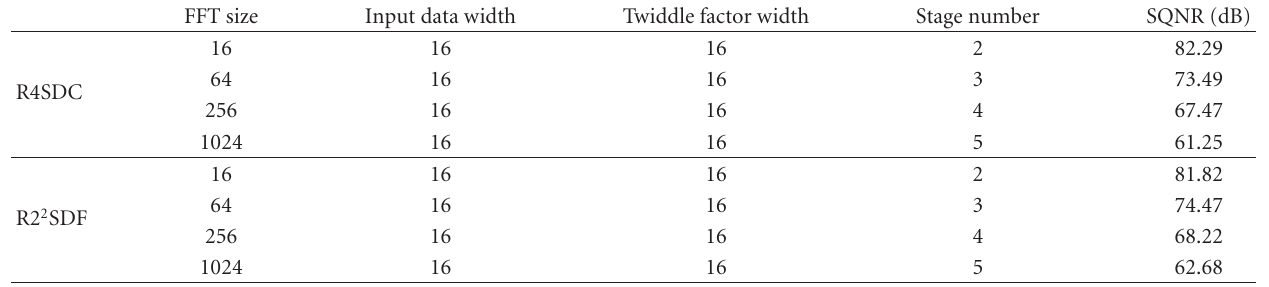
Table 3: SQNR with di ff erent FFT sizes.